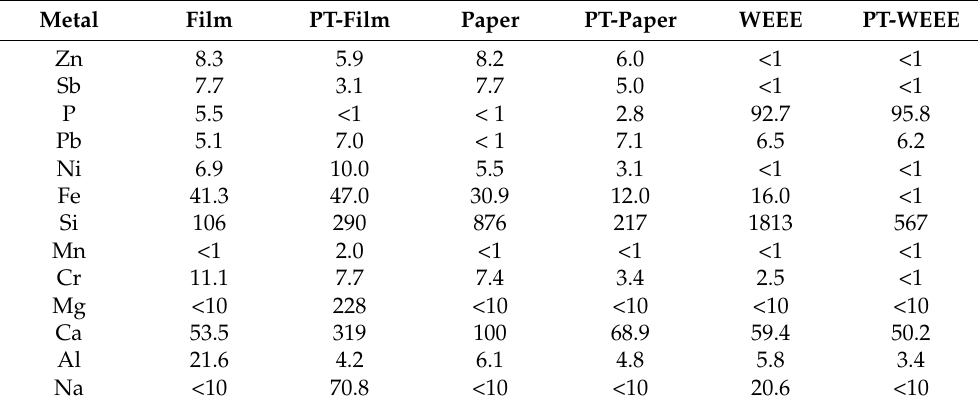
Table 8. Metal content (ppm) in the pyrolysis oils from raw and pre-treated